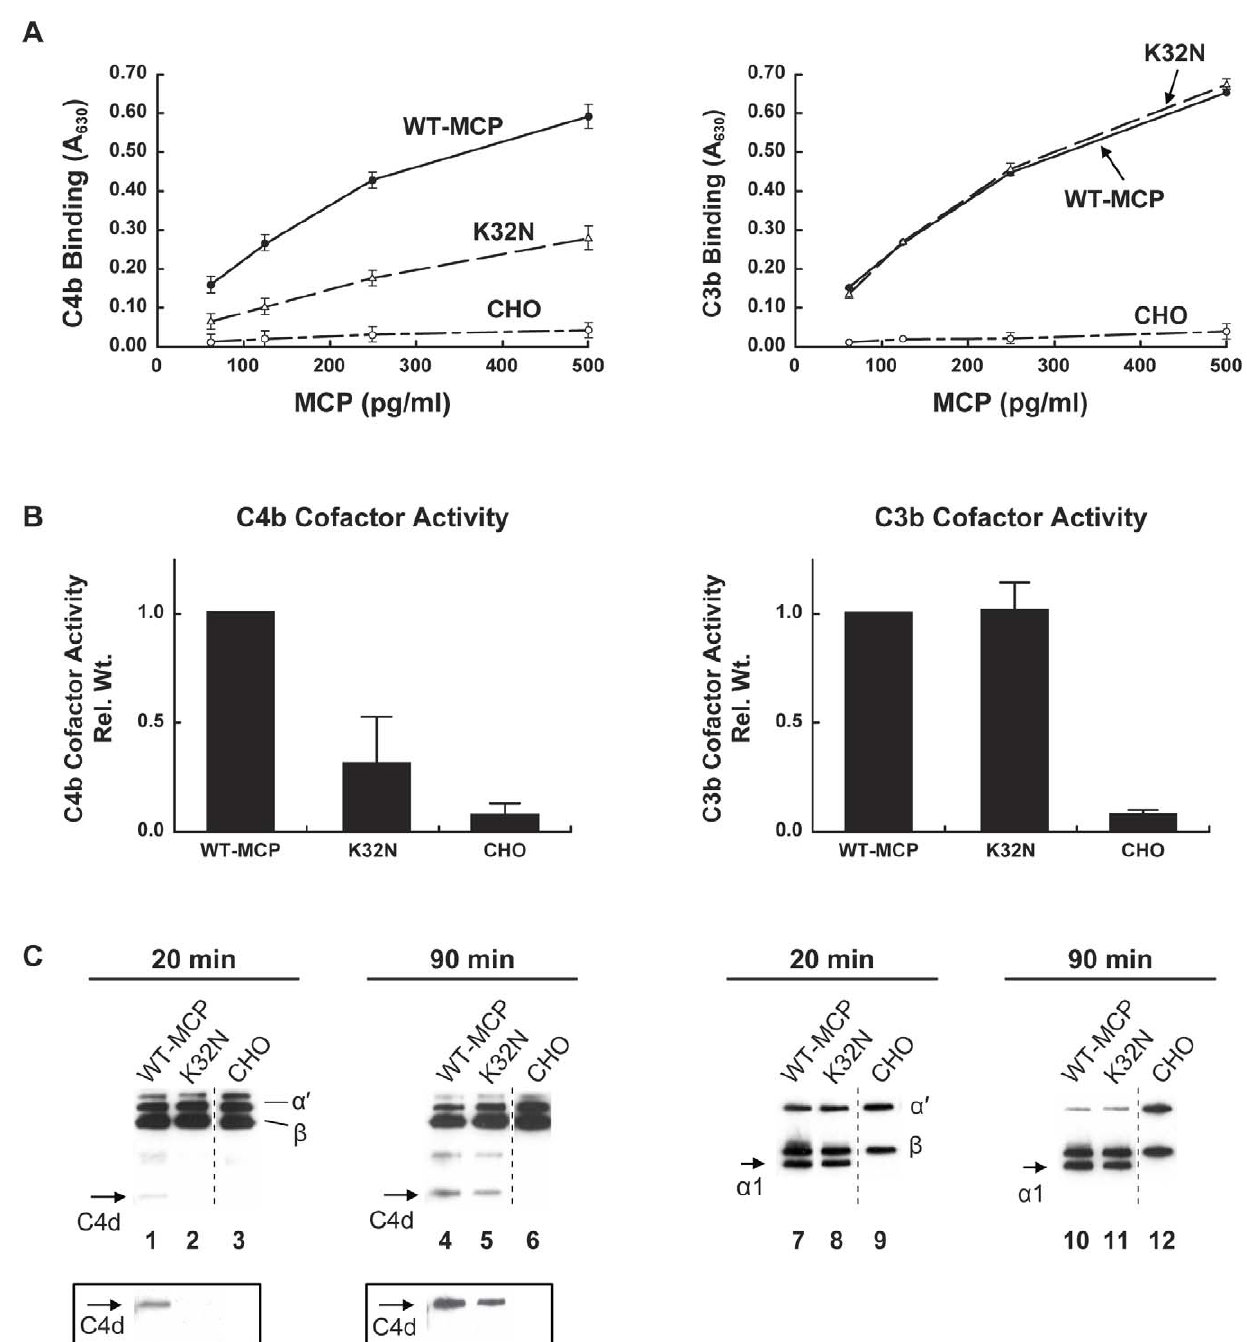
Figure 2. C3b and C4b binding and cofactor activity of K32N compared to wild type MCP. (A) C4b and C3b binding. CHO cell lysates from transient transfections were incubated with C4b- or C3b-coated wells and binding was assessed using a polyclonal antibody to MCP in an ELISA format. CHO, a mock transfected control. Data represent the mean 6 standard deviation at each concentration from three independent experiments. (B) Cofactor activity for CFI-mediated cleavage of C4b and C3b. Cell lysates containing 25 pg of MCP (wild-type or K32N) were incubated with biotinylated C4b or C3b in the presence of purified human CFI in 25 mM NaCl and cleavage was assessed by Western blot. C4b and C3b peptide chains and cleavage fragments are identified. For C4b cofactor activity, C4d fragment generated by cleavage of C4b after 90 min was quantified by densitometric scanning, compared with quantity of b chain, and normalized to wild type. For C3b cofactor activity, a 1 fragment generated by cleavage was compared to b chain by densitometry, and normalized to wild type. Data represent the mean 6 standard deviation of three independent experiments. (C) Representative Western blots of MCP activity for CFI-mediated cleavage of C4b and C3b. Left panel: MCP K32N has deficient C4b cofactor activity at 20 and 90 min. The C4dfragmentgenerated by cleavage of the a 9 chain is not visibleat 20 min andis diminished relative to wild type at90 min. Theboxedinserts represent 5-fold longer exposure of the blot. The CHO negative control was a nonadjacent lane (broken line). Right panel: MCP K32N has similar C3b cofactor activity to wild type. Equal amounts of a 1 fragments are generated after 20 and 90 min. The CHO negative control was a nonadjacent lane (broken line). In two additional experiments, similar results were obtained in cofactor assays at 150 mM NaCl concentration (unpublished data).